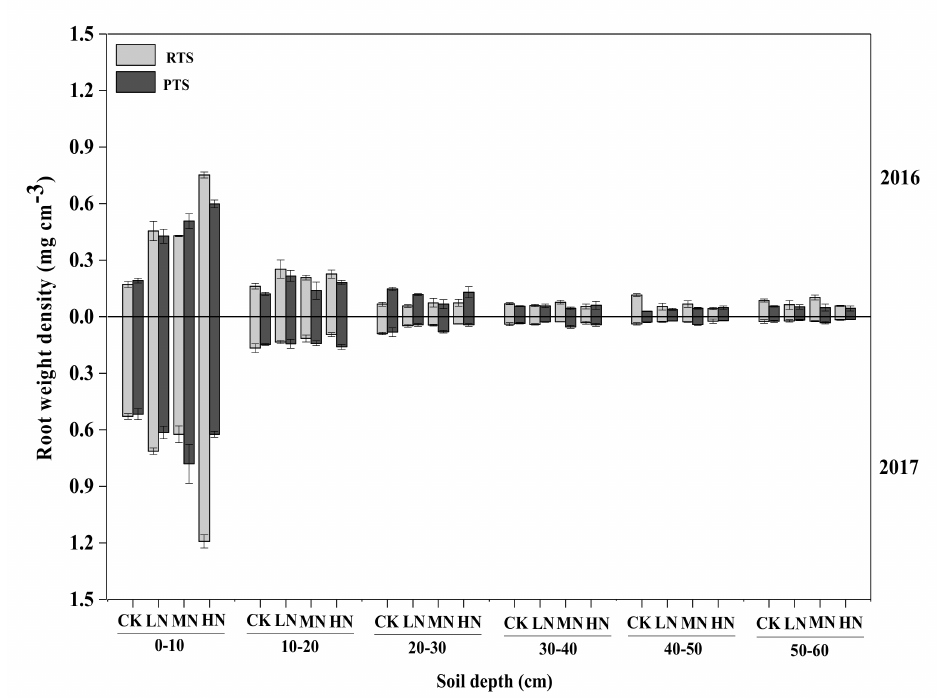
Figure 4. Response of root weight density to tillage with straw incorporation and N treatment in 2016–2017. RTS, rotary tillage with straw incorporation; PTS, plow tillage with straw incorporation. CK, LN, MN, and HN indicate 0, 112, 187, and 262 kg N ha − 1 applied,